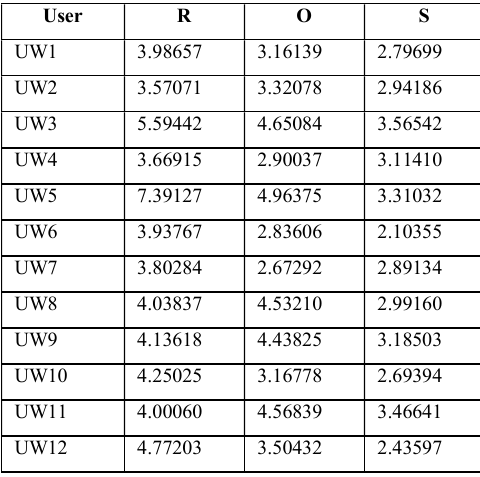
Fig. 20 t-Test of average speed of SP vs